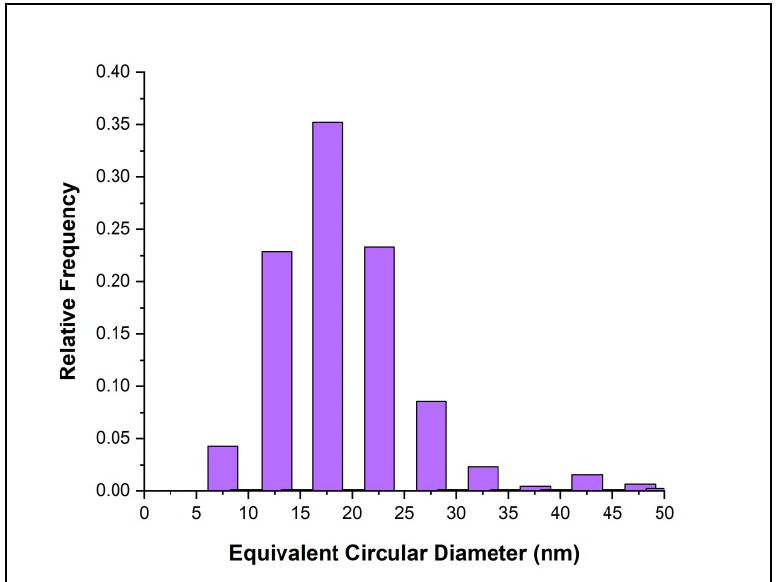
Figure 13. Histogram plot of Mo precipitate for M9.8 WQ aged at 550 °C for 120 min.